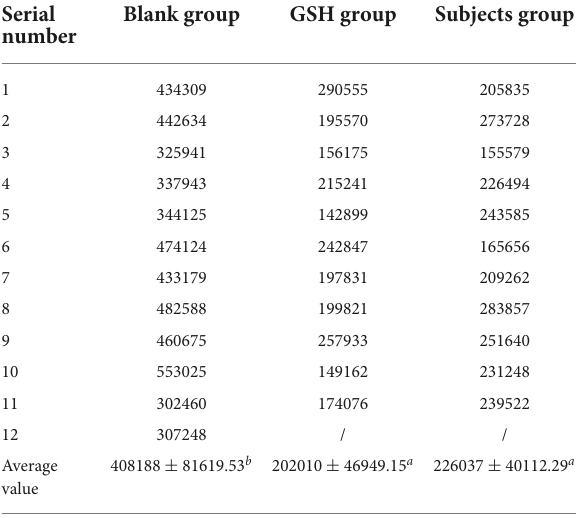
TABLE 5 Fluorescence grayscale values for each